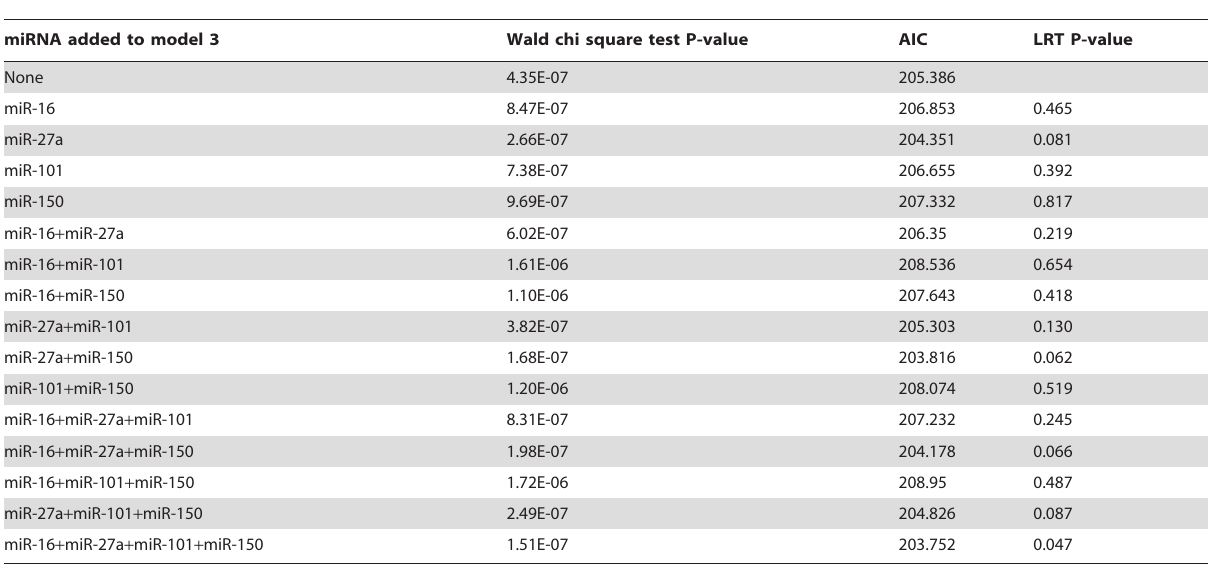
Table 5. Added value of combinations of miRNAs (censored regression).